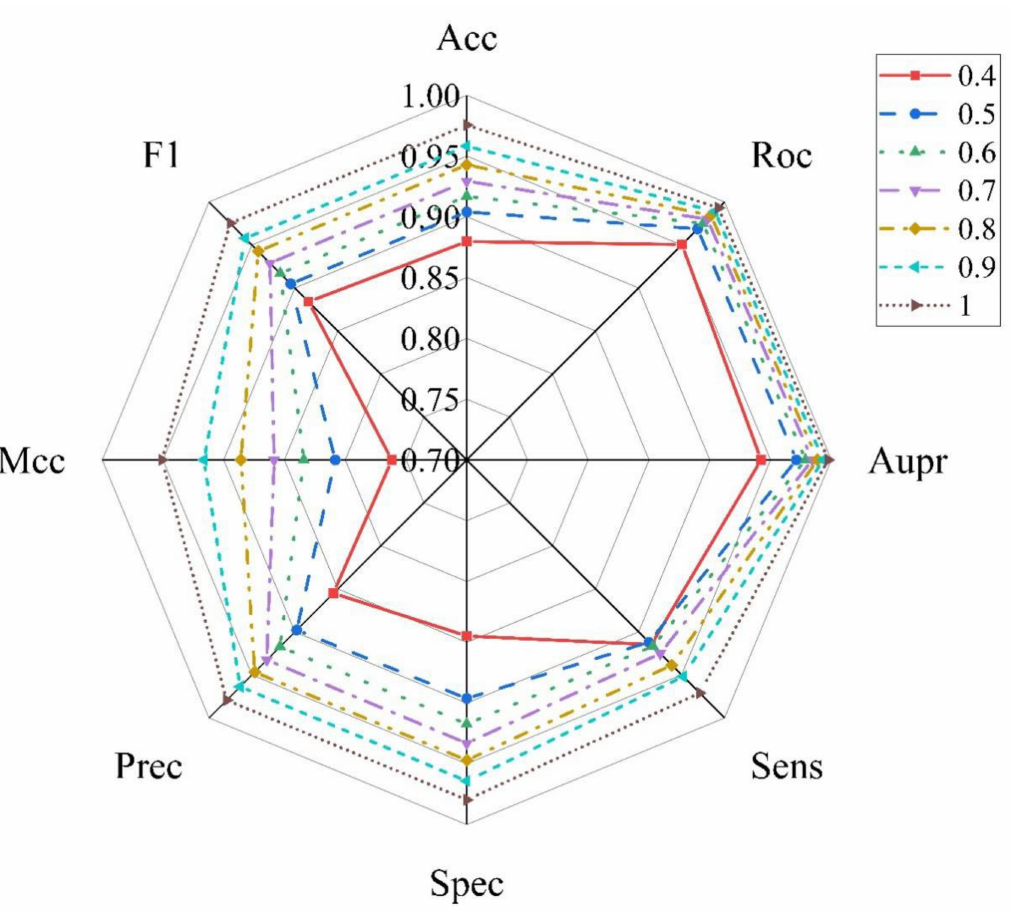
Figure 10. Performance comparison of different thresholds of negative samples.